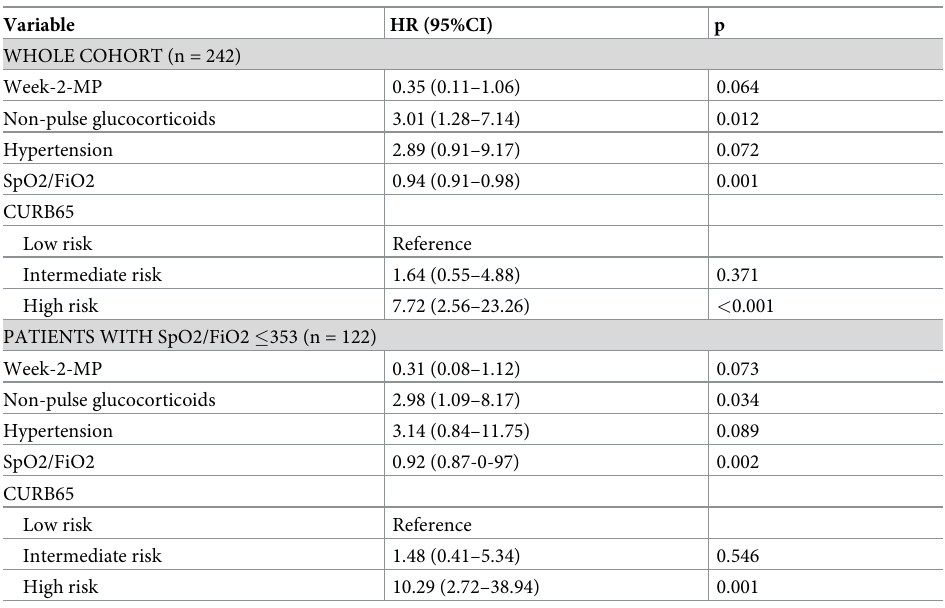
Table 2. Predictors of death: Final